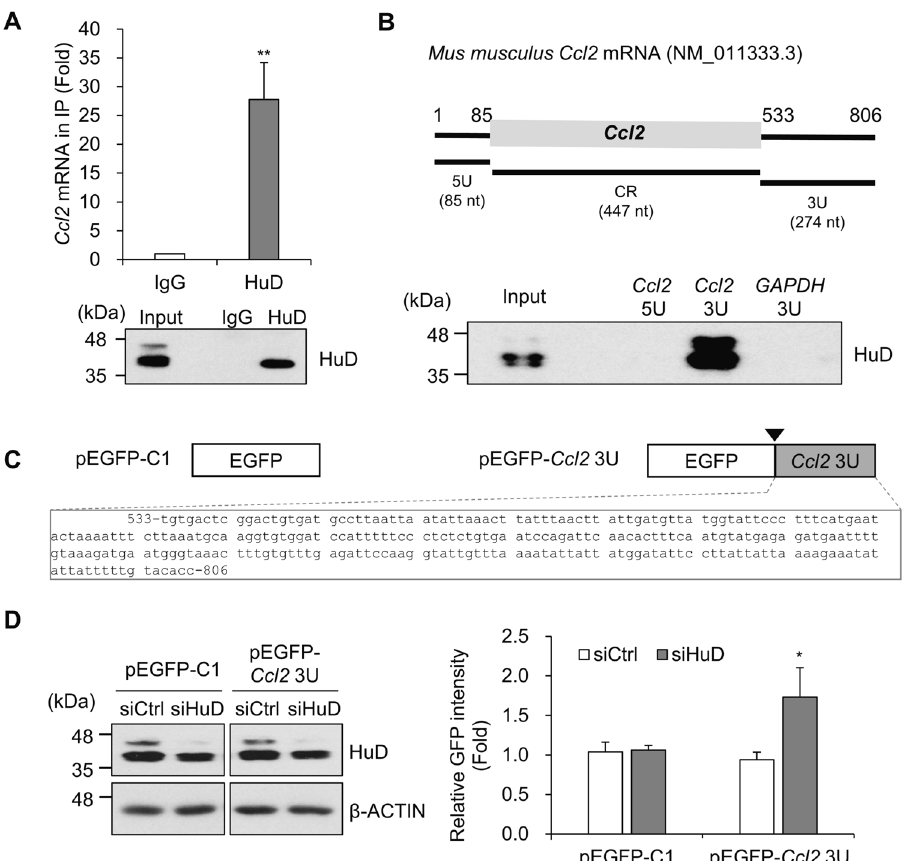
Fig. 4 Interaction between HuD and 3 ′ UTR of Ccl2 mRNA. A The interaction between HuD and Ccl2 mRNA was con fi rmed by RNA IP followed by RT-qPCR using anti-HuD and control IgG antibodies. Gapdh mRNA was used for normalization. B Top: A schematic of mouse Ccl2 mRNA (NM_011333.3). The UTRs of Ccl2 mRNA (5U and 3U) were transcribed in vitro using T7 RNA polymerase and biotin-labeled nucleotides. Bottom : The biotinylated transcripts ( Ccl2 5U, Ccl2 3U, and GAPDH 3U) were incubated with the lysate from N2a cells. The proteins binding to the transcripts were pulled-down using streptavidin magnetic beads and analyzed via western blotting using HuD antibody. Biotinylated GAPDH 3U was used as a negative control. C Schematic diagram of EGFP reporters. The reporter plasmid (pEGFP- Ccl2 3U) was constructed by inserting the 3 ′ UTR of Ccl2 mRNA (533 – 806 nt) into the pEGFP-C1. ( ▼ : stop codon). D After sequential transfection with siRNAs and EGFP reporter plasmids, relative fl uorescence of EGFP from each sample was measured by fl uorescence microscopy and the levels of HuD and β -ACTIN were assessed by western blotting analysis. Images are representative, and data indicate the mean ± SEM from three independent experiments. The statistical signi fi cance of the data was analyzed via Student ’ s t -test; * p < 0.05; ** p <